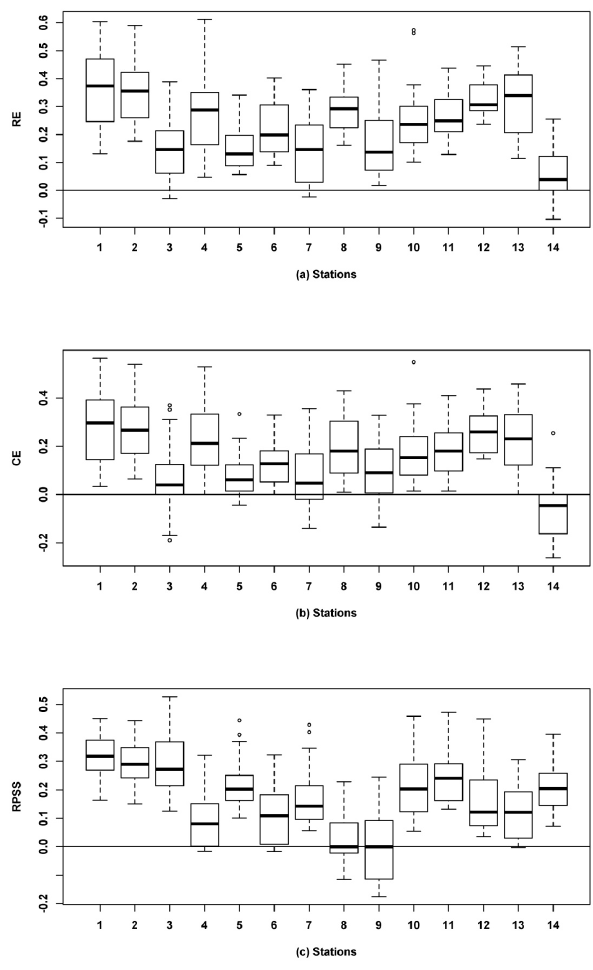
Fig. 7. Performance under “leave-10-out cross-validation” for all 14 Figure7: Performance under “leave 10 out cross validation” for all 14 stations from stations from the hierarchical Bayesian model from 30 random sim- ulations – (a) reduction of error (RE), (b) coefficient of efficiency the hierarchical Bayesian model from 30 random simulations ((a) Reduction of Error (CE), (c) Rank probability skill score (RE), (b) Coefficient of Efficiency (CE), (c) Rank probability skill score (RPSS)).